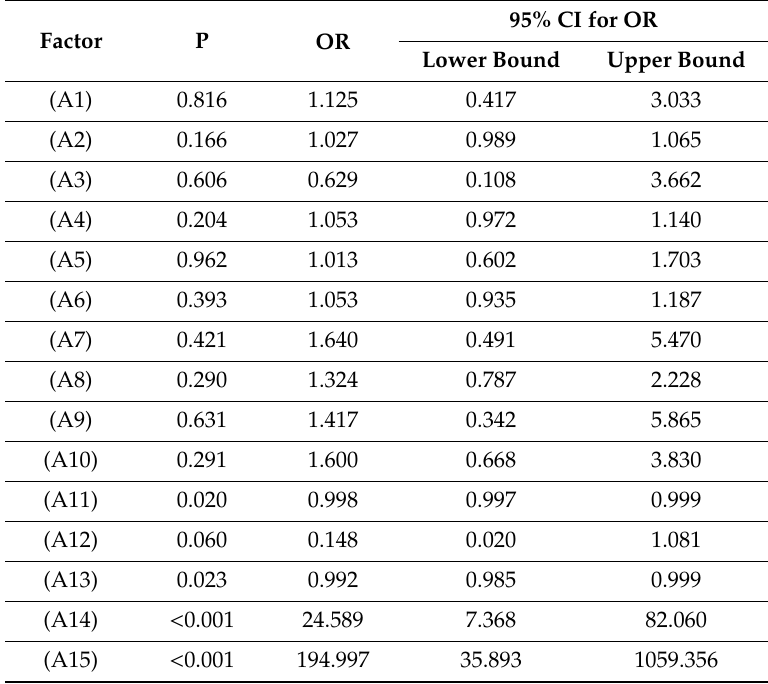
Table 6. Odds ratio values for bleeding risk factors (univariate logistic